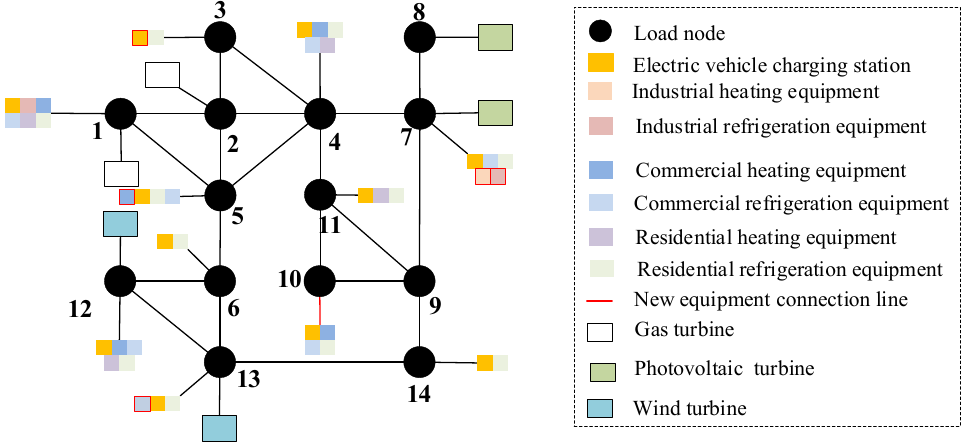
Figure 20. Morphological evolution of distribution network in 2024. Table 1. Resource allocation results of distribution network from 2020 to 2025.